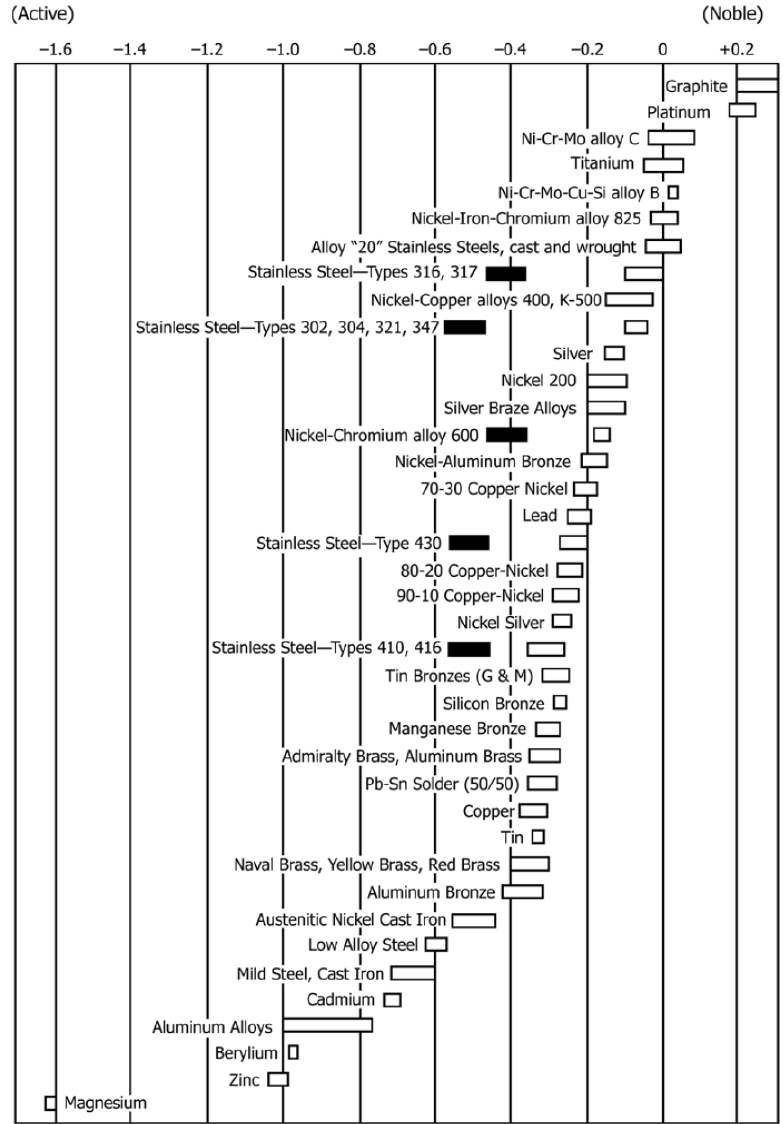
Figure 25. A galvanic series of various metals and alloys in flowing seawater at 2.4 to 4.0 m s –1 for 5 to 15 days at 5 to 30 ◦ C. Dark boxes indicate active behaviour of active-passive alloys. Values of top axis: volts versus SCE. Source: ASTM G82–98(2014) [295].